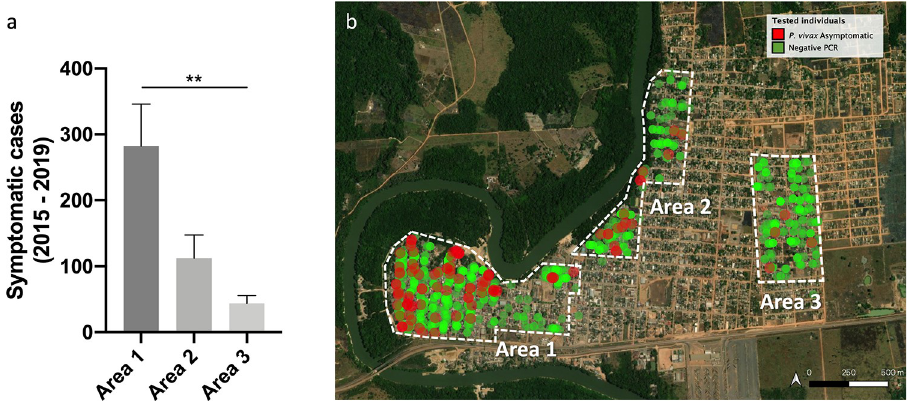
Fig 2. Asymptomatic individuals distribution correlate with symptomatic cases. (a) Mean and standard deviation of officially notified symptomatic cases between the studied areas from 2015 to 2019. (b) Spatial distribution of asymptomatic infections between the 3 areas studied in Candeias do Jamari, RO. Map was built using QGIS using base layers from USGS source: Esri, Maxar, GeoEye, Earthstar Geographics, CNES/Airbus DS, USDA, USGS, AeroGRID, IGN, and the GIS User Community. (Available on